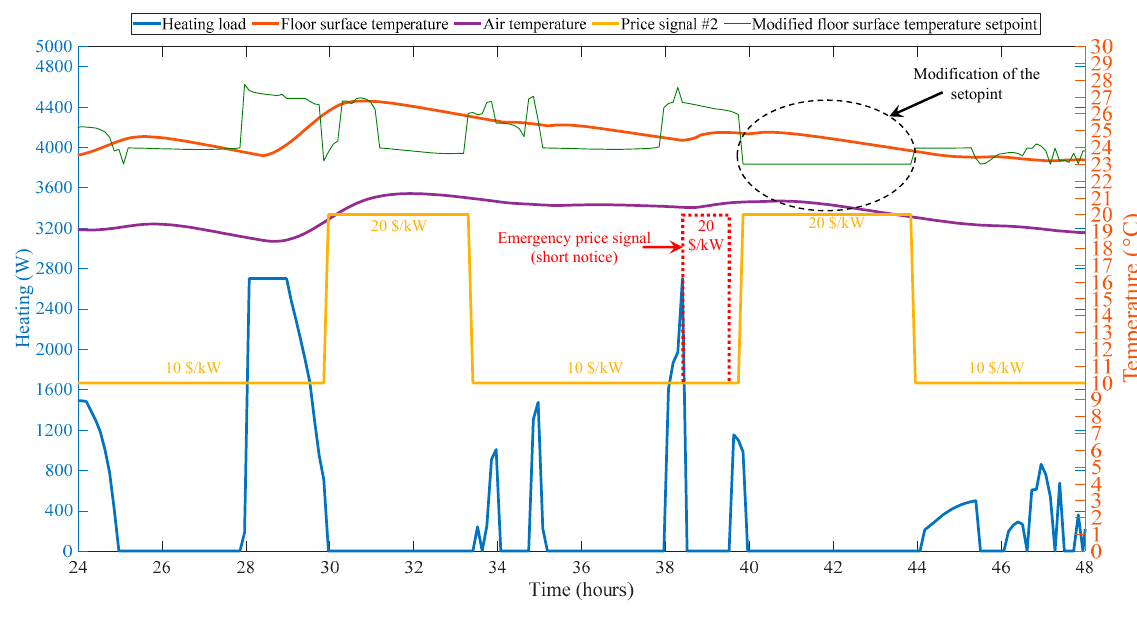
Figure 18. Modified setpoint to correct the heating load.